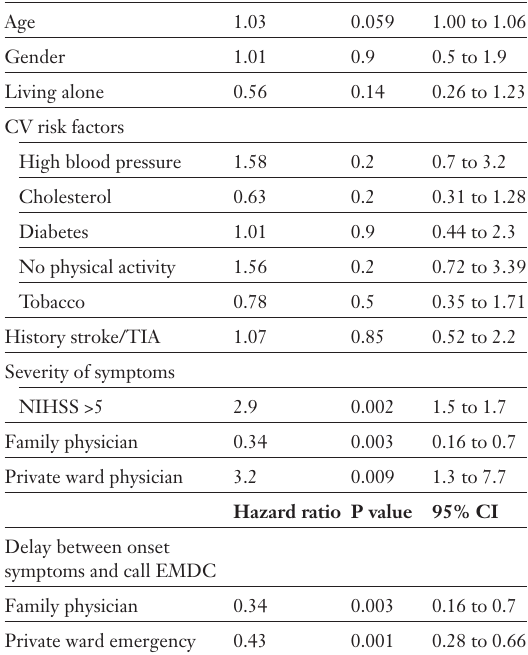
Prediction of use of the Emergency Med- ical Dispatch Center (EMDC) and delays between onset of symptoms and call to the EMDC (n =